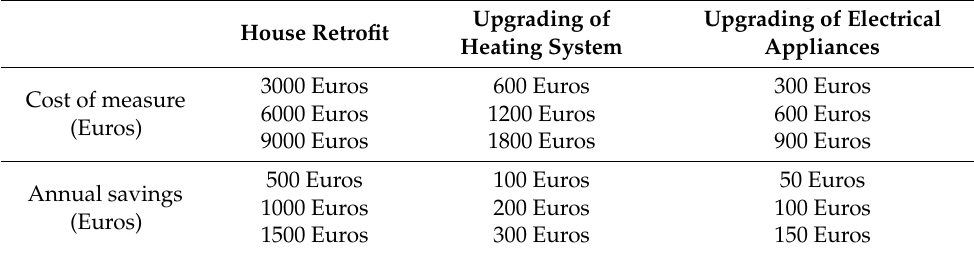
Table 1. Levels of the attributes for each of the three labeled alternatives. Upgrading of Upgrading of House Retrofit